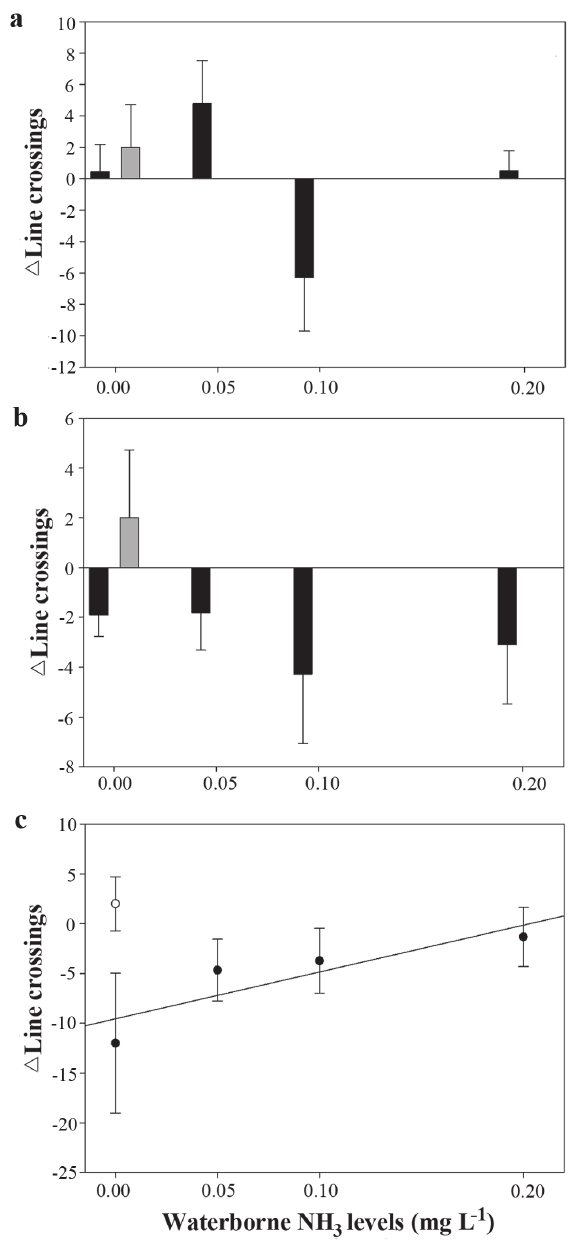
Fig. 4. Change in the number of line crossings (mean ± SE) before and after exposure to skin extract (black dots or bars) and distilled water (grey dots or bars) on days 1 ( a ), 5 ( b ) and 10 ( c ) of exposure to different waterborne NH 9.54 + 47.01x, where y =  line crossings and x = waterborne NH levels (mg L -1 3